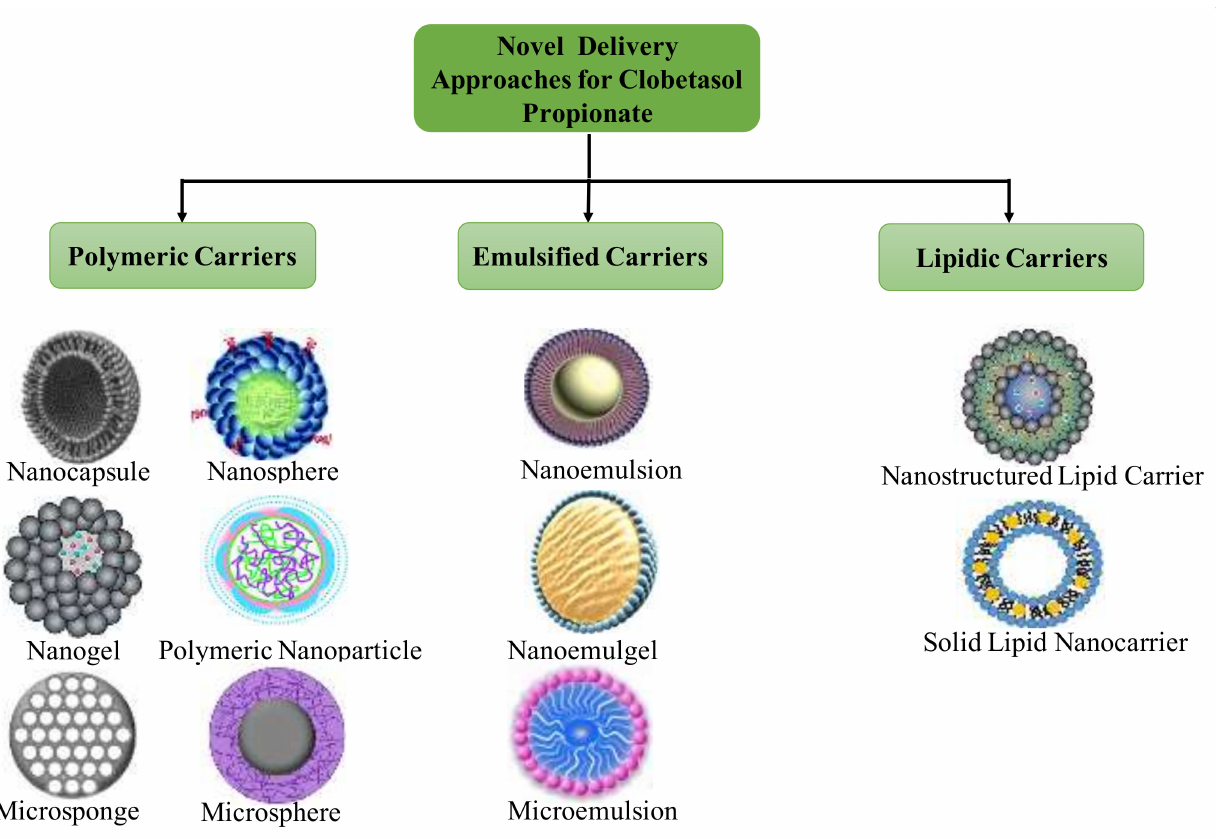
Figure 1. Novel cargos for clobetasol propionate delivery.